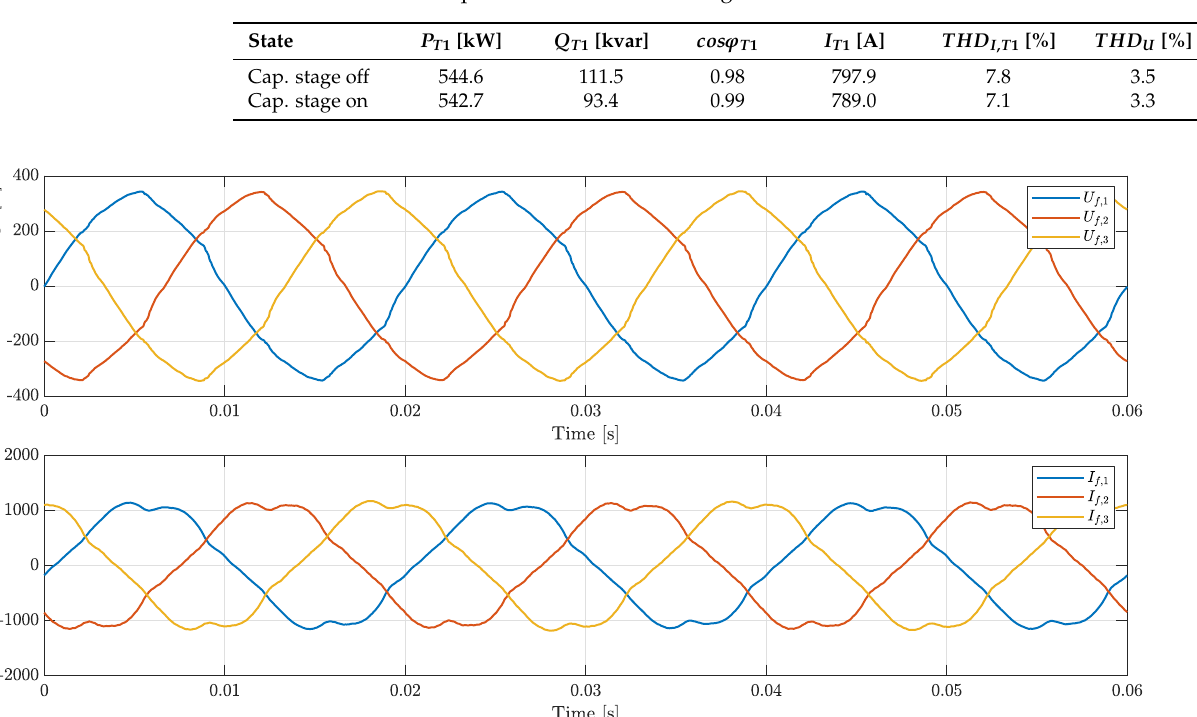
Table 1. C1: Electrical quantities on the low-voltage side of the transformer station.